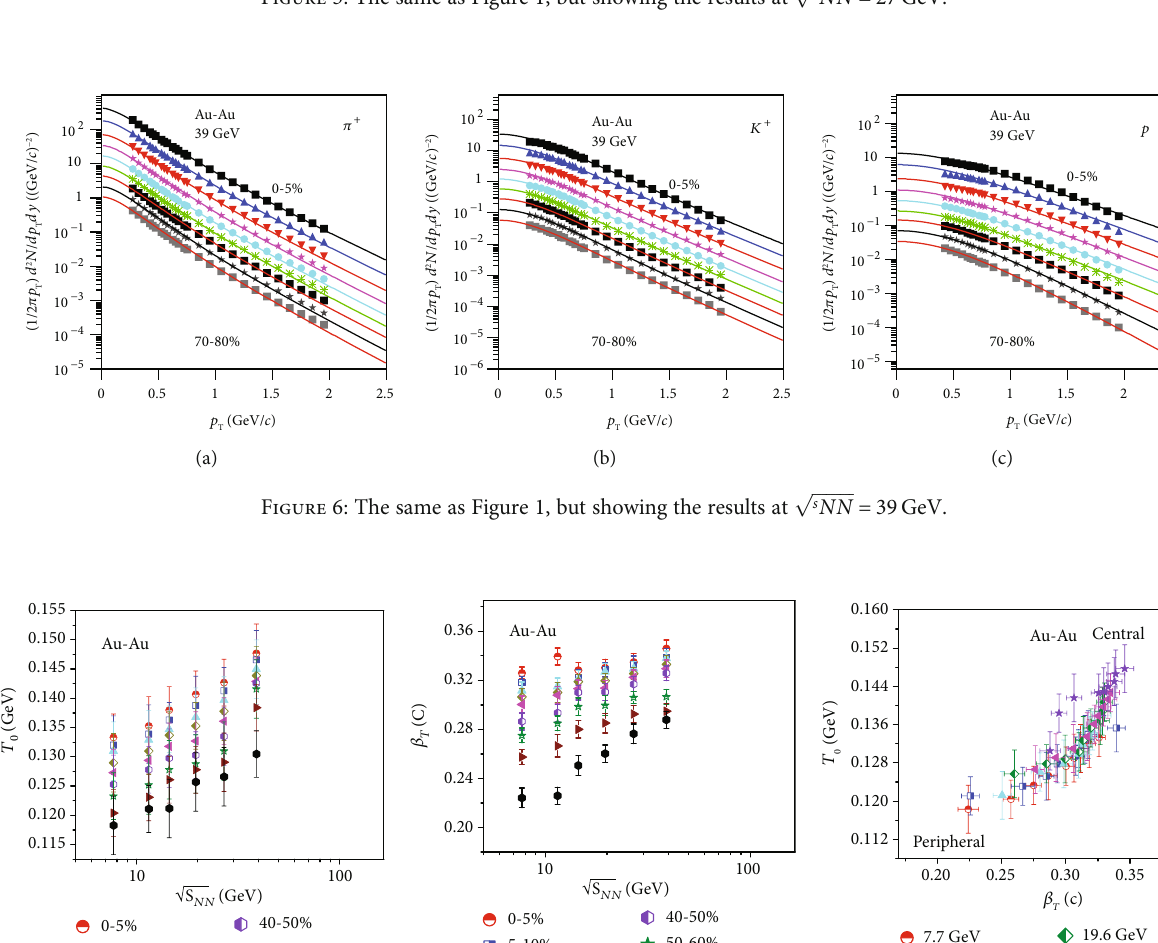
Figure 5: The same as Figure 1, but showing the results at